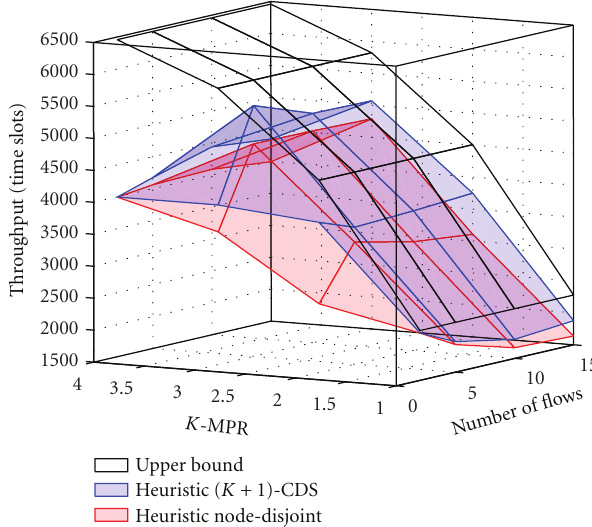
Figure 9: The throughput of upper bound and heuristics.